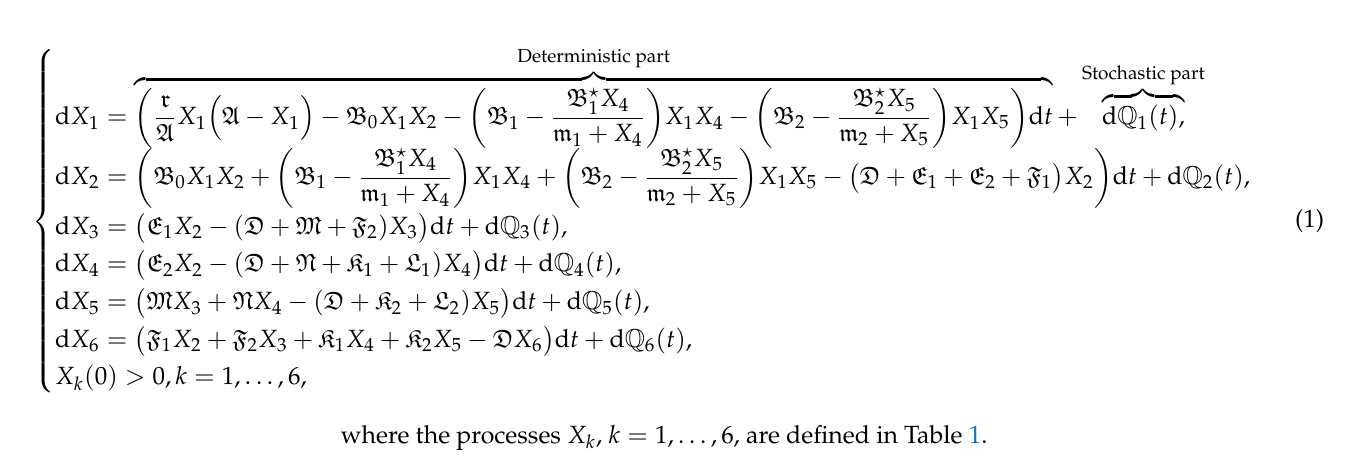
Table 1. Classification of different types of individuals. Symbol Epidemiological Classification X 1 Susceptible persons X 2 Exposed persons X 3 Isolated persons X 4 Infected persons X 5 Hospitalized persons X 6 Recovered persons